Question: Briefly state, in one sentence, what is plotted here.
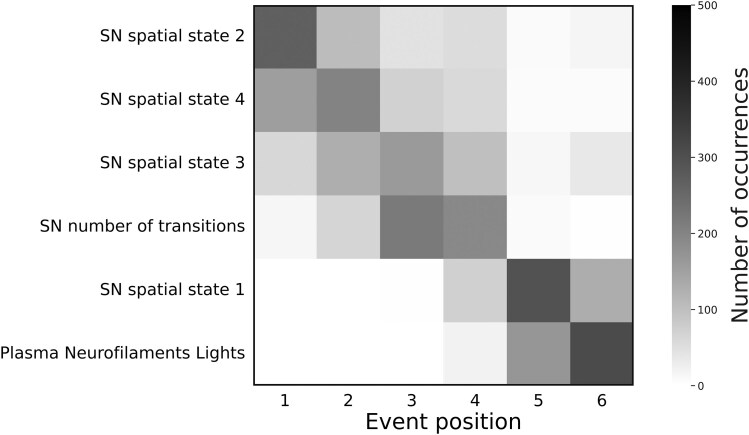
Answer: Positional variance diagrams of event ordering obtained with Discriminative Event-Based Model (DEBM). SN = Salience Network. Event ordering generated via the Discriminative Event-Based Model (DEBM) algorithm. The greyscale indicates how many times an event was placed at a specific position across the 500 bootstrapped iterations, with darker tones indicating a more consistent positioning of the event ( N = 711).